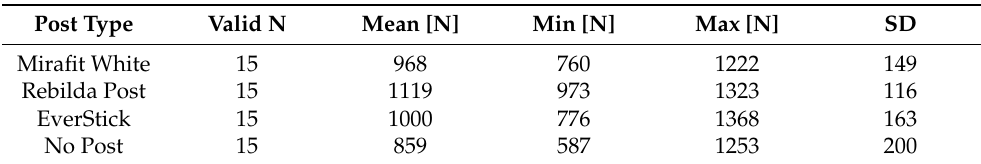
Figure 3. Sample orientation for best occlusal contacts. Table 1. Fracture thresholds as well as the significance of their difference of studied fibre-reinforced teeth compared to the control